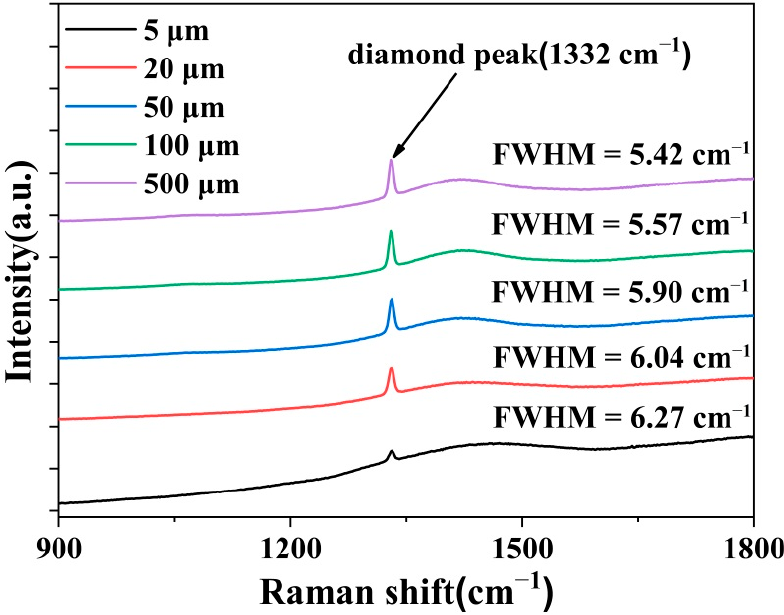
Figure 6. Raman spectra at different diamond cross-section positions above the diamond/Ir inter- face.